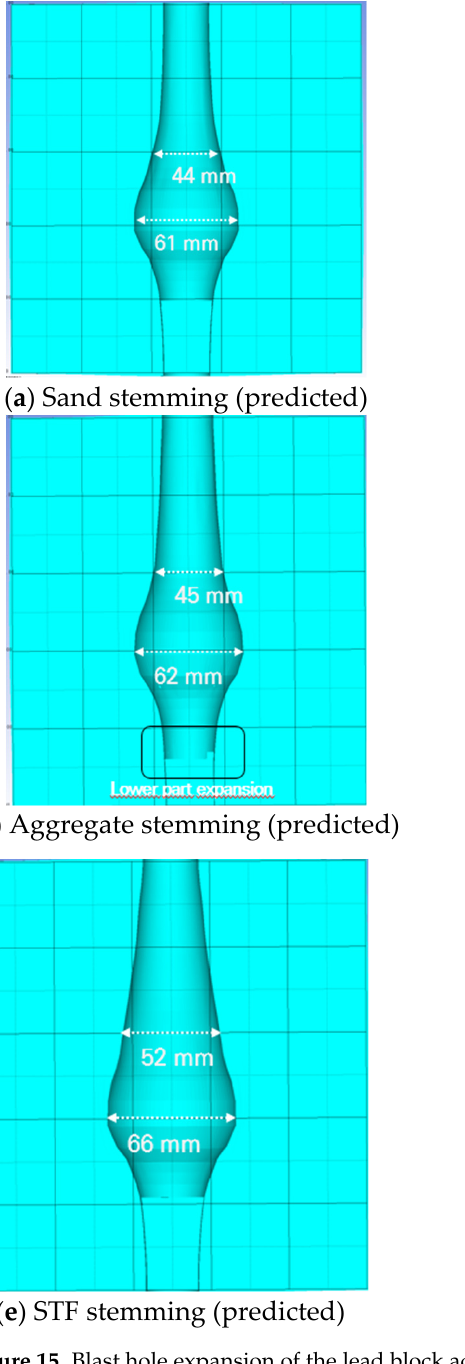
Figure 15. Blast hole expansion of the lead block according to different stemming materials.